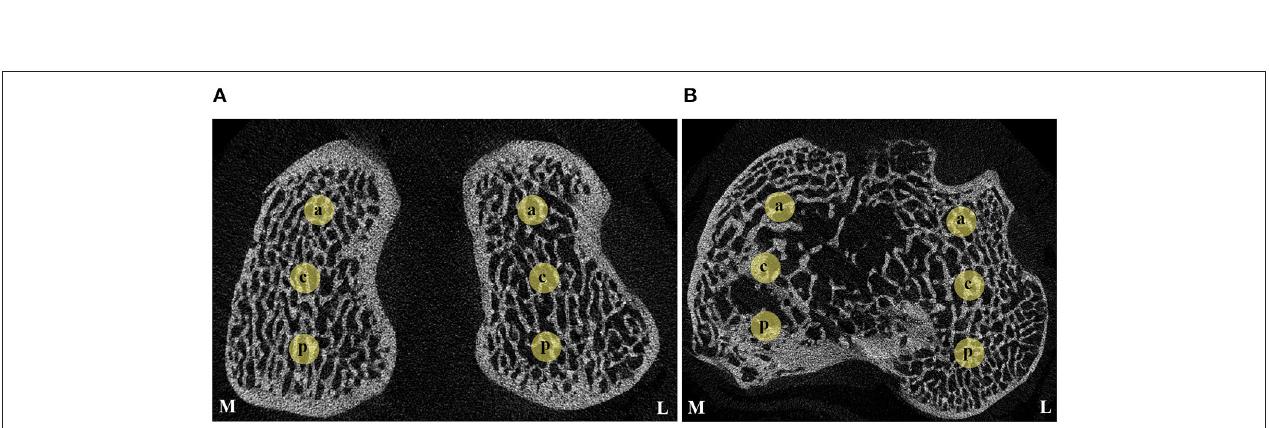
FIGURE 4 | Transverse micro-CT slices indicating the anatomical VOIs of cancellous bone evaluated. (A) Distal femur; (B) Proximal tibia. M, medial; L, lateral; a, anterior; c, central; p, posterior.